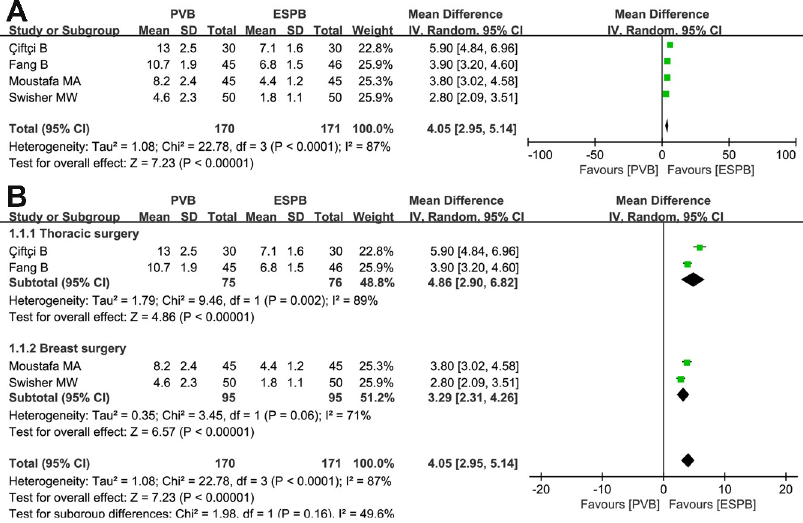
Fig 8. Forest plots of the time required for completing block procedure. (A) Analysis of all data in the associated studies; (B) Subgroup analysis by differentiating thoracic surgery or breast surgery.